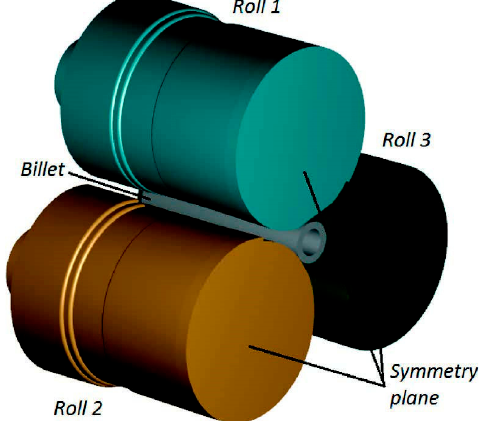
Figure 10. Three-roll cross-wedge rolling [10] (Reprinted from ref. [10]).